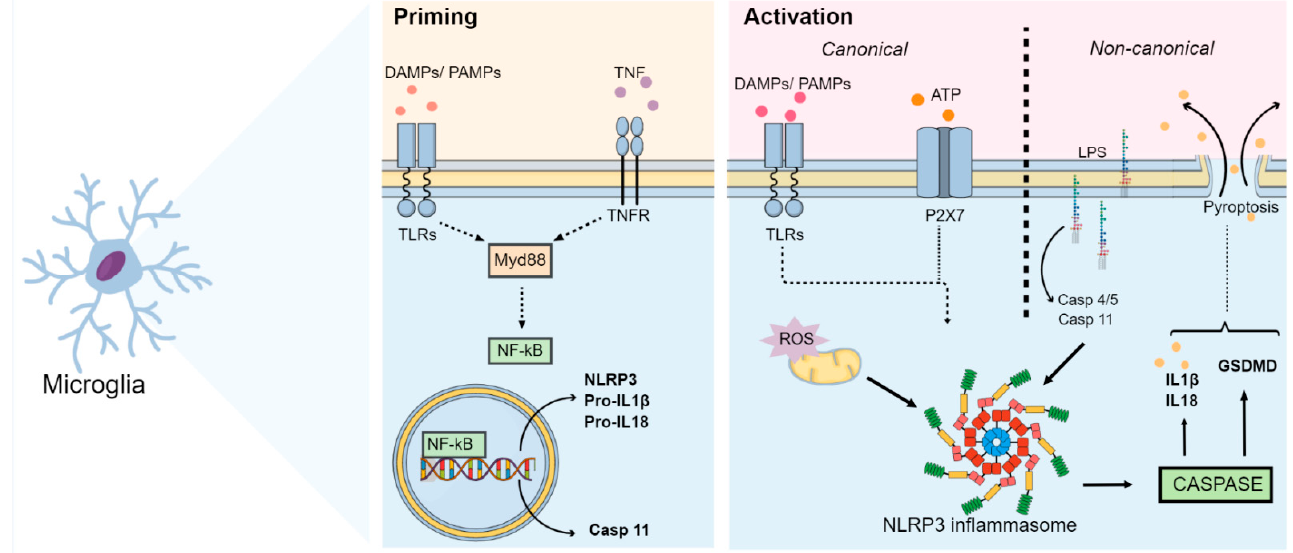
Figure 1. NLRP3 inflammasome pathways. After an insult, the NLRP3 inflammasome initiation step occurs. During this step, DAMPs, PAMPs and cytokines (such as TNF- α ) interact with TLRs, NLRs or cytokine receptors (such as TNFR). This interaction induces the activation of the Myd88 and NF-kB pathways. Activated NF-kB then translocates to the nucleus and induces the expression of NLRP3, pro-IL-1 β , pro-IL-18 and caspase-11 (through the non-canonical pathway). During this activation step, several stimuli culminate in different cellular and molecular signaling events, such as mitochondrial dysfunction, lysosomal damage, calcium and potassium ion flux, ROS synthesis, and ATP release. These events activate the NLRP3 inflammasome, which cleaves procaspase-1 and releases the active form of caspase-1. Caspase-1 then cleaves pro-IL-18 and pro-IL-1 β into their active forms and activates GSDMD, thus inducing pyroptosis. Synthesis of IL-1 β and IL-18 as well as activation of GSDMD by NLRP3 may also occur via a non-canonical pathway, in which LPS binds directly to caspases 4/5 in humans and caspase-11 in mice. Abbreviations: DAMPs: damage-associated molecular patterns; GSDMD: gasdermin D-mediated membrane pore formation; IL: interleukin; LPS: lipopolysaccharide; Myd88: myeloid differentiation primary response 88; NF-kB: nuclear factor kappa B; NLR: nucleotide-binding oligomerization domain-like receptor; NLRP3: Nod-like receptor pyrin containing 3; PAMPs: pathogen-associated molecular patterns; TLRs: Toll-like receptors; TNF- α : tumor necrosis factor; TNFR: tumor necrosis factor